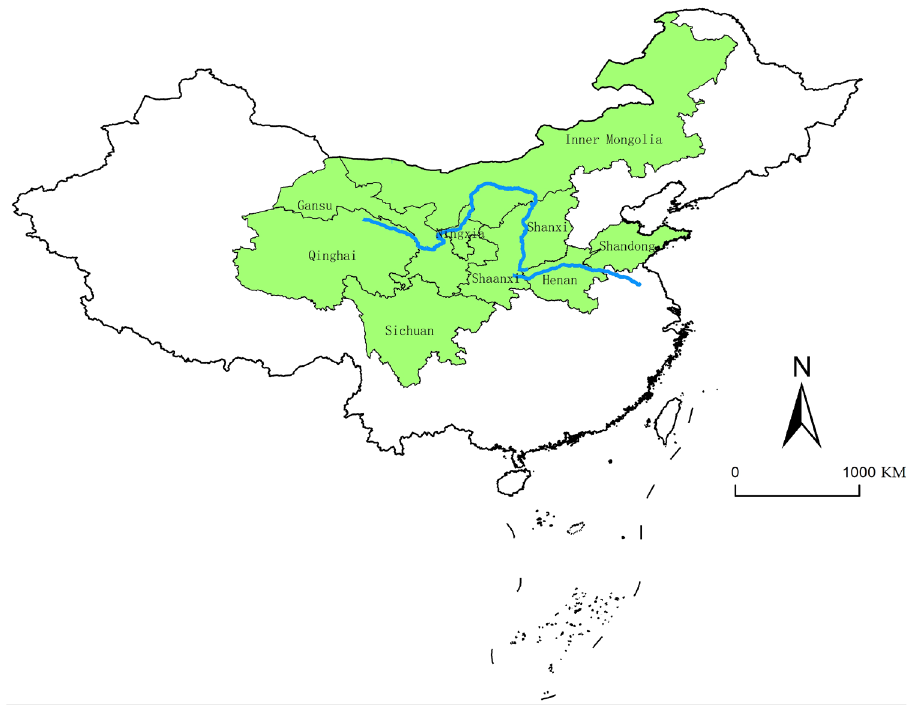
Figure 2. Geographical location of the study area in China.